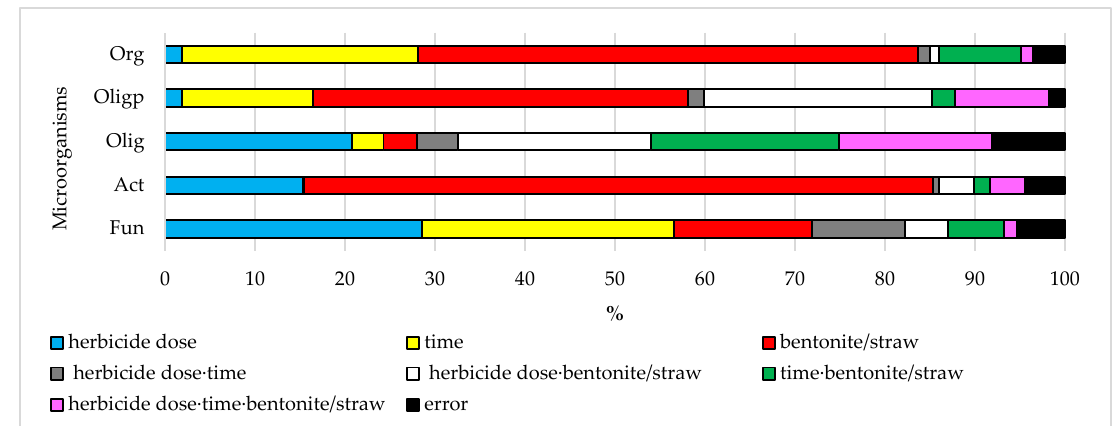
Figure 1. Percent of the observed variability microorganisms η 2 in soil contaminated with Successor T 550 SE. Org—organotrophic bacteria; Oligp—sporeforming oligotrophic bacteria; Olig—oligotrophic bacteria; Act—actinobacteria; Fun—fungi.